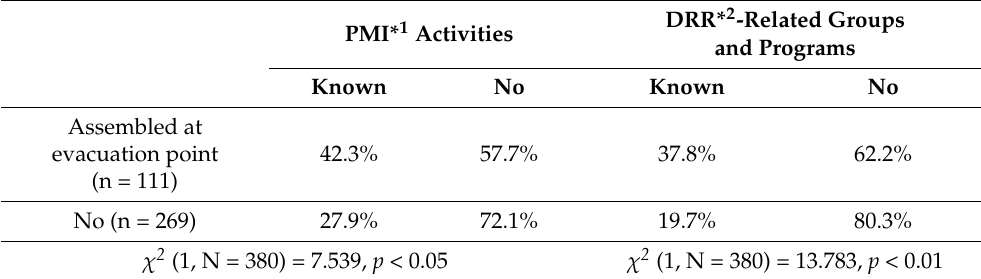
Table 14. Preparedness (knowledge) and immediate evacuation (N = 380).